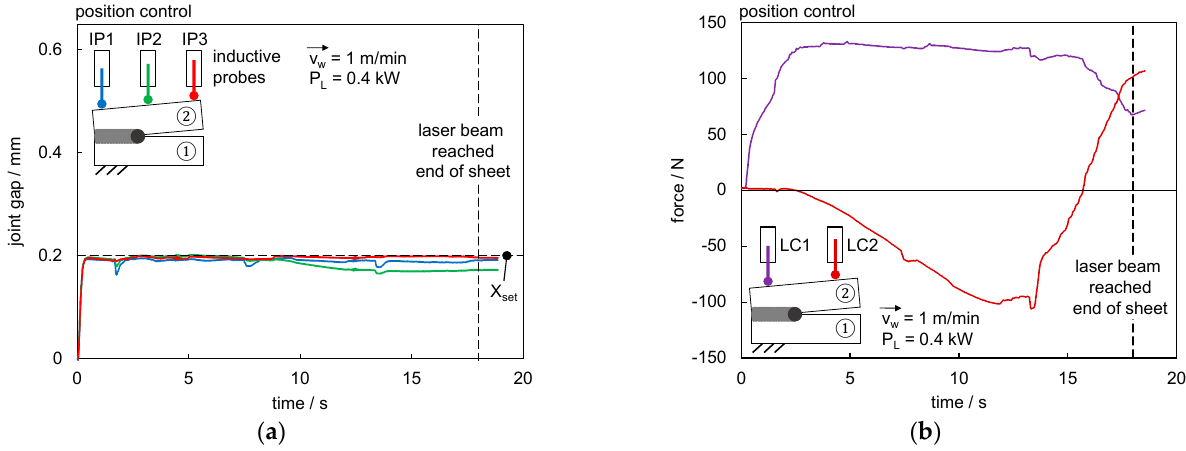
Figure 11. Closed-loop position control (v w = 1 m/min, P L = 0.4 kW): ( a ) Gap measurement via inductive probes; ( b ) Force measurement via load cells.